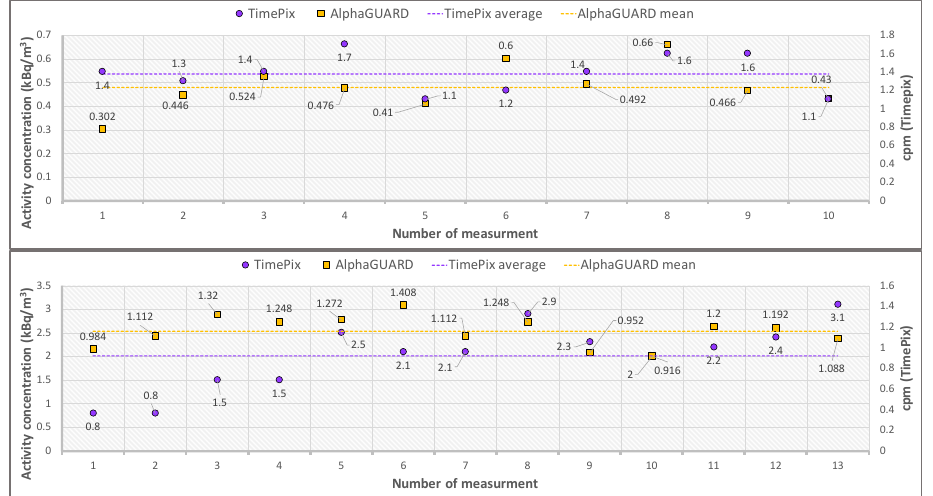
Figure 8. Time series of data acquired by TimePix and the AlphaGUARD are shown for Exposure 2 and 3 (for the run characteristics, see Table 1). Upper canvas—Exposure 2: time series of the radon concentration activity (AlphaGUARD, yellow squares) and the α cpm values registered by the TimePix (purple circles). The mean radon activity concentration (dotted yellow line) results equal to 0.48 ± 0.05kBq/m 3 and the mean α cpm value (purple dotted line) is 1.26 ± 0.21. Lower canvas— Exposure 3: time series of the radon concentration activity (AlphaGUARD, yellow squares) and of the α cpm values registered by the TimePix (purple circles). The mean radon activity concentration (dotted yellow line) results equal to 1.16 ± 0.12kBq/m 3 and the mean α cpm value (purple dotted line) is 2.01 ± 0.48. The statistical errors are evaluated as the standard deviations of the time